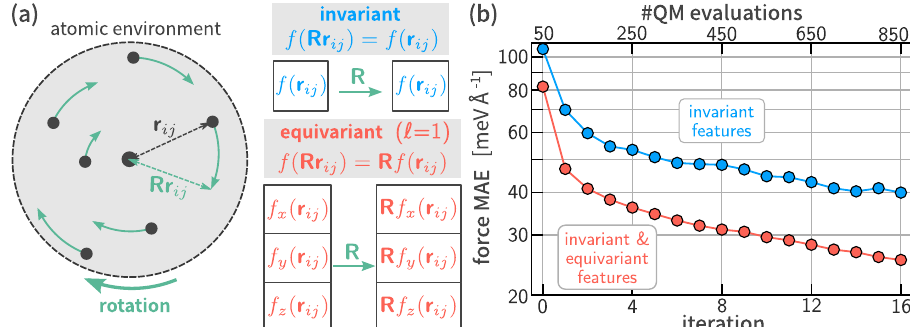
Fig. 3 Comparison between invariant and equivariant feature representations. a Features in equivariant neural networks are associated with a speci fi c irreducible representation of SO(3), as characterized by the rotation order ℓ . For ℓ = 0, features do not transform upon rotation of the system, and may be considered as scalars. For ℓ = 1, features transform according to vectors in R 3 . b Evolution of the test error as a function of the number of iterations in the incremental learning algorithm as well as the total number of QM evaluations that were performed for both the invariant ℓ max ¼ 0 model (blue) and equivariant ℓ max ¼ 1 model (red). The test system was UiO-66(Zr). Computational details regarding network hyperparameters, MTD parameters, and test set generation can be found in the Methods section as well as the Supplementary Information.